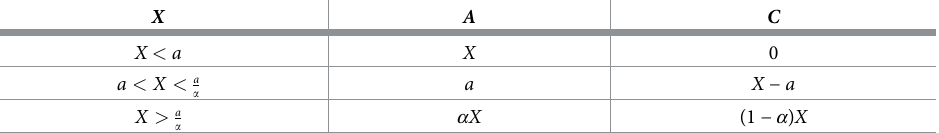
Table 7. Definition of A and C if a mixture of absolute deductible a > 0 and proportional deductible α 2 (0, 1) is applied. X A C X <